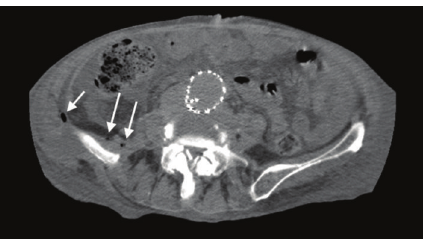
Figure 5: Abscess formation within the retroperitoneal